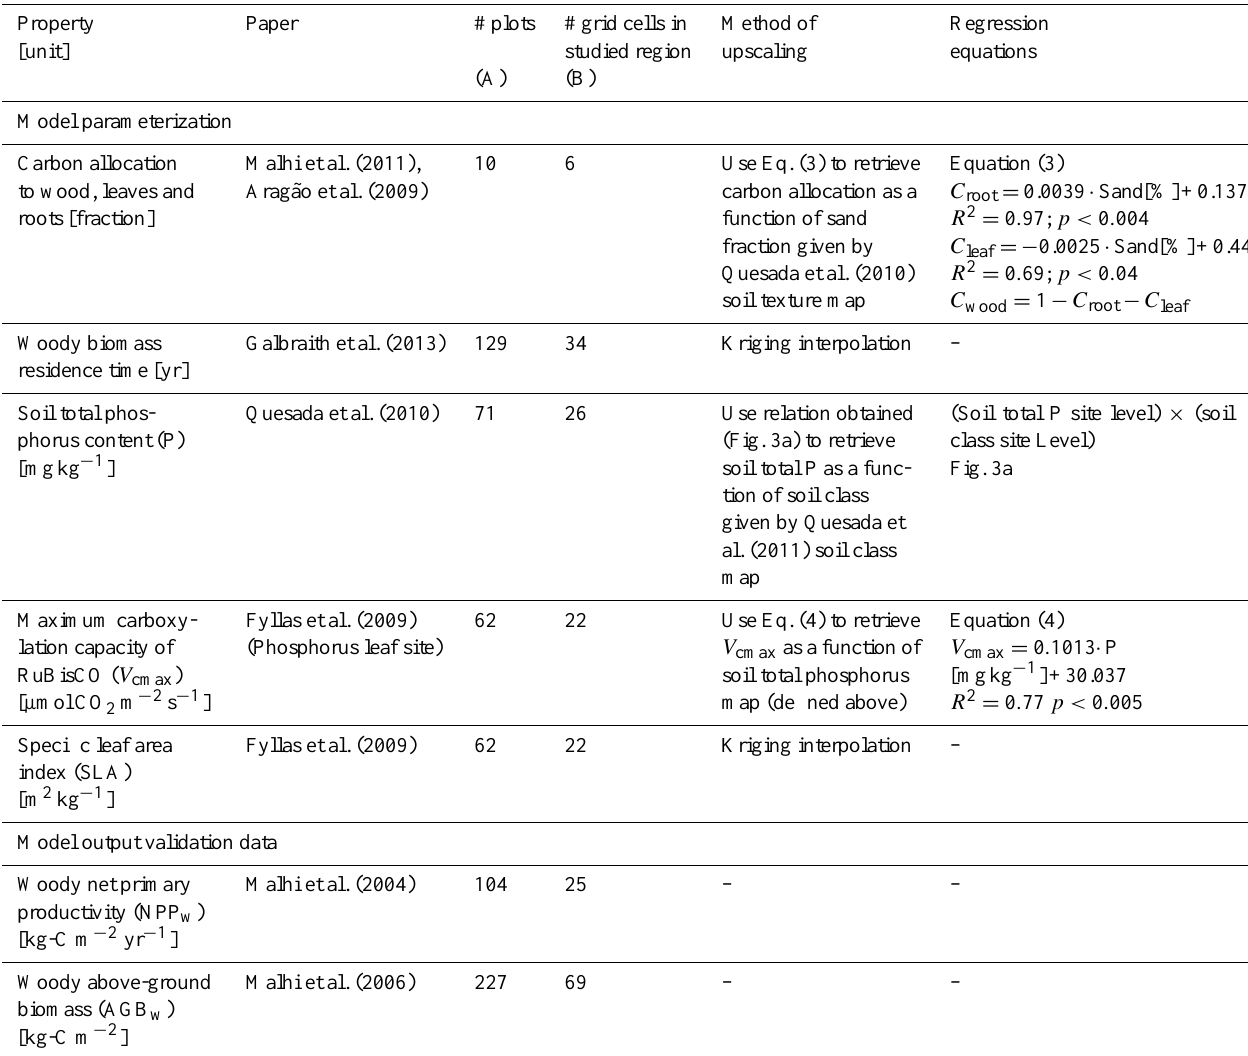
Table 1. List of field data used in this study with the respective reference in the literature. The original number of plots from each study is presented in column A, the respective number of grid cells at 1 ◦ × 1 ◦ resolution is presented in column B. The methods for upscaling and the regression equations used are presented. The table is divided into field data used for input parameterization in the model and field data of woody net primary productivity and woody above-ground biomass used for model output